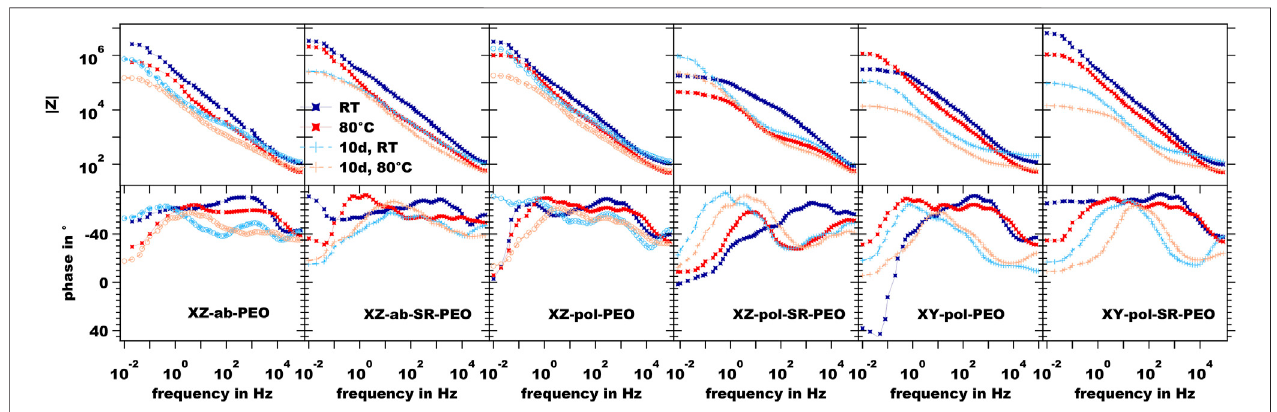
FIGURE 11 | EIS measurement results of the PEO-coated